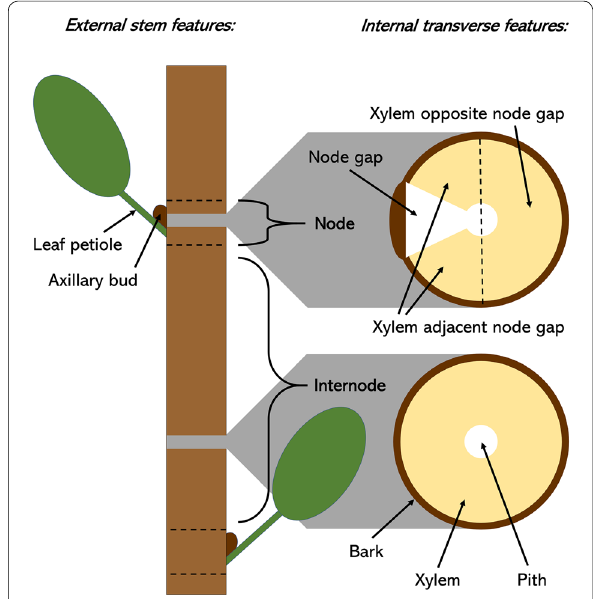
Fig. 1 Anatomical features of nodes within current-year woody shoots